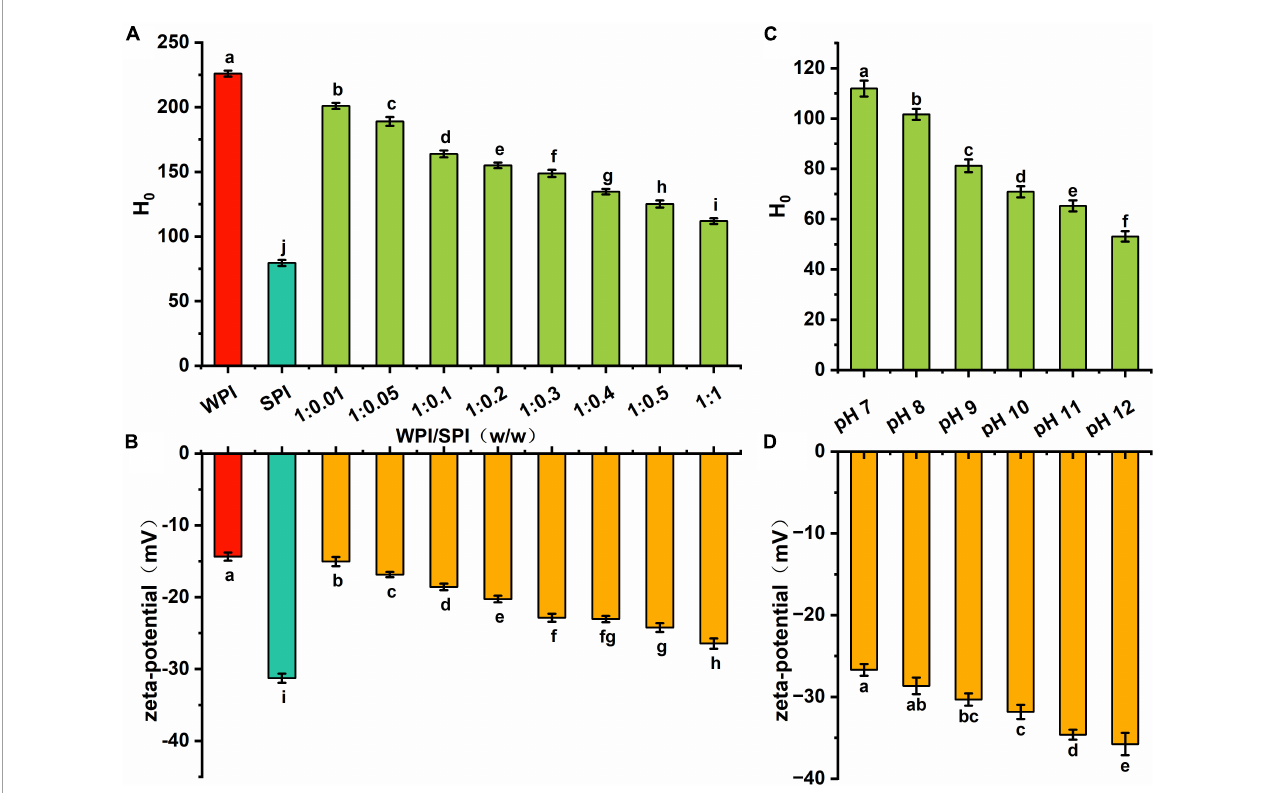
FIGURE7 (A) The hydrophobicity of WPI, SPI and the composite nanoparticles at pH 7; (B) the zeta-potential of WPI, SPI and the composite nanoparticles at pH 7; (C) the hydrophobicity of the composite nanoparticles prepared at WPI: SPI ration of 1:1 at pH 12, 11, 10, 9, 8, and 7; (D) the zeta-potential of the composite nanoparticles prepared at WPI: SPI ration of 1:1 at pH 12, 11, 10, 9, 8, and